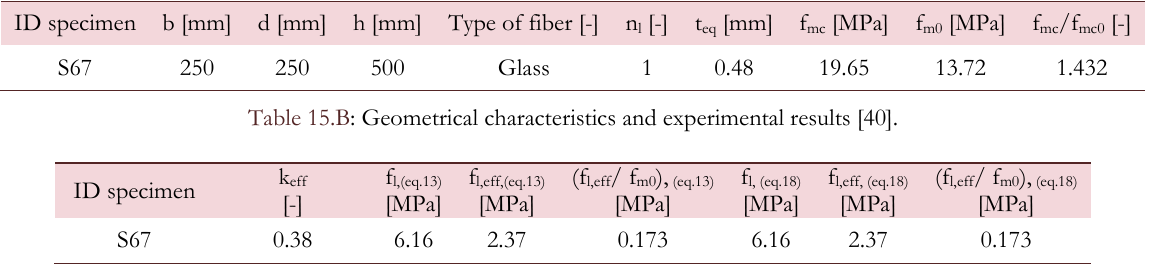
Table 16.B: Effective confining stress calculated according to Eqns. (13) and (18) for the experimental program,